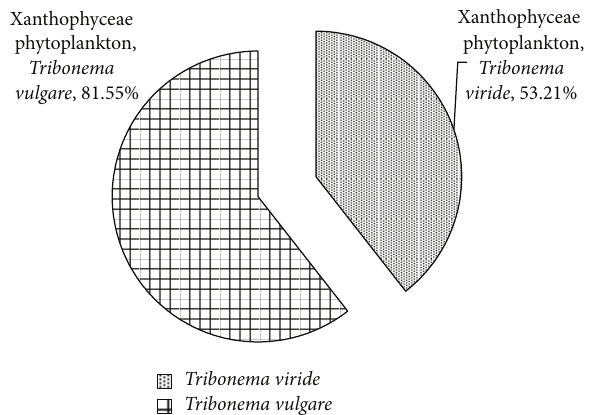
Figure 14: Overall mean values of Xanthophyceae species in Okpoka Creek.